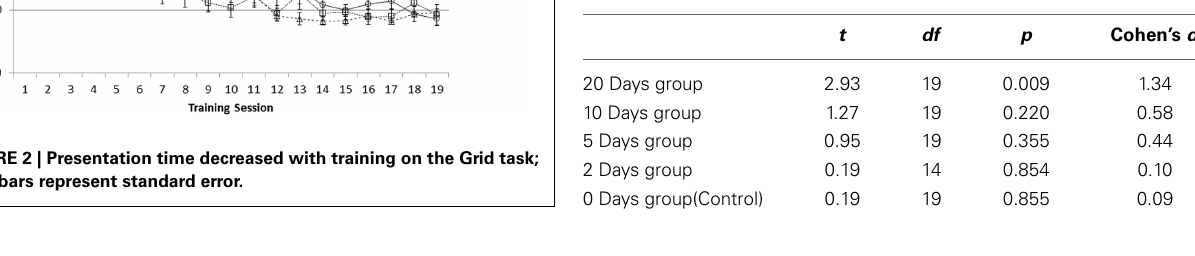
Table 3 | Improvement on SPM after the training as reflected by paired-sample t -test.